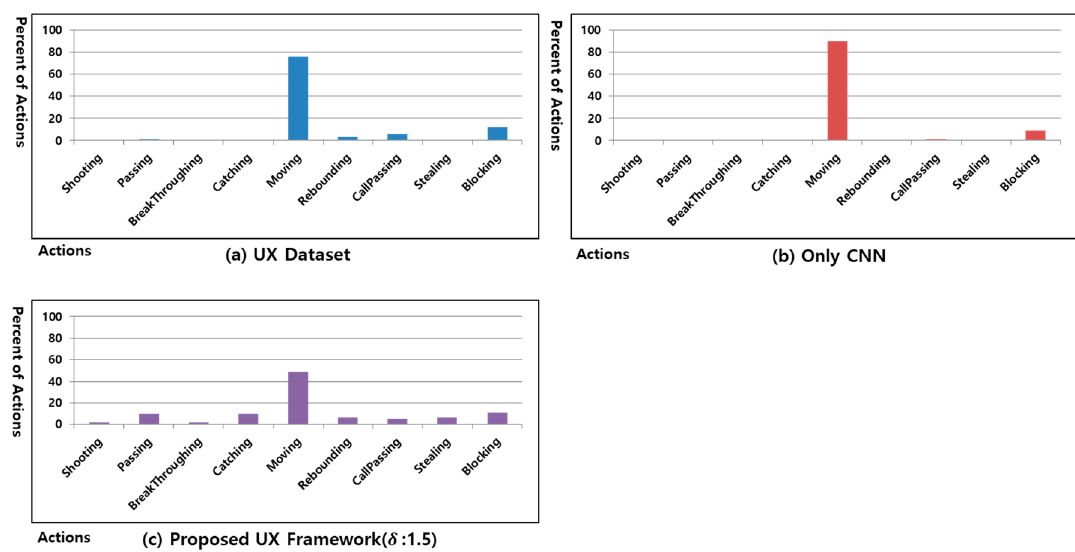
Figure 10. Percentage of actions of proposed UX framework in Freestyle game of user #3.